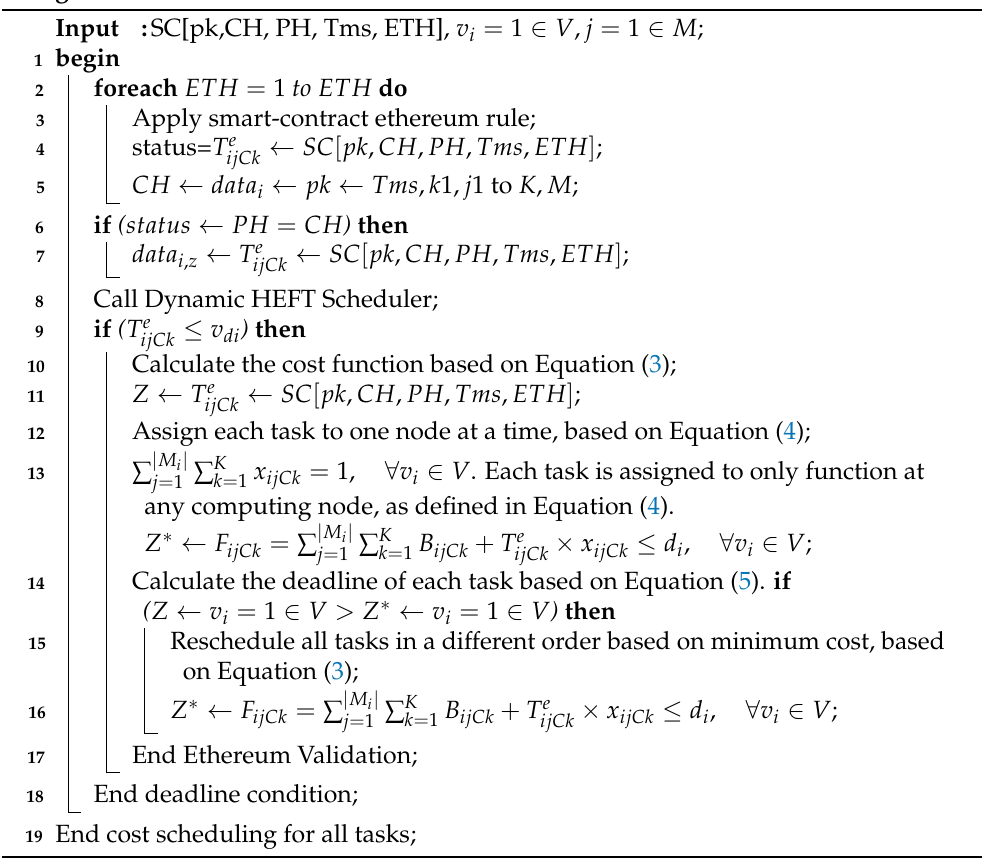
Algorithm 4: Ethereum